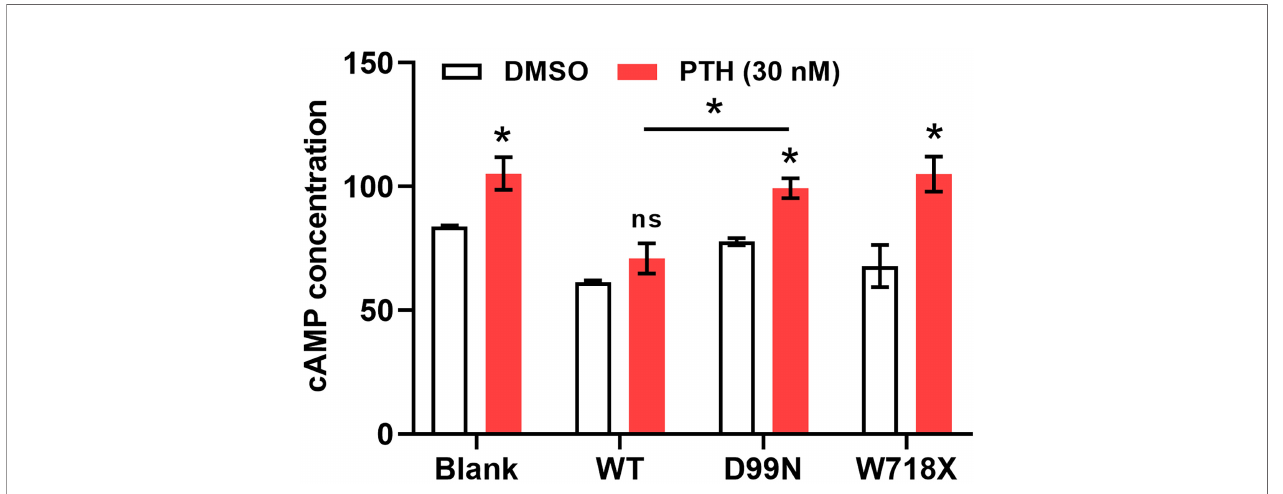
FIGURE 6 | Measurement of cAMP levels in response to PTH. Intracellular cAMP levels in all groups following treatment with dimethyl sulfoxide (control) or 30 nM PTH. *P < 0.05, ns for no signi fi